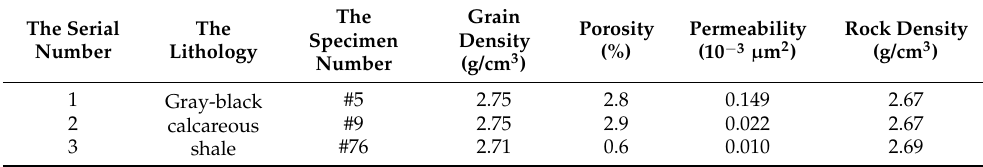
Table 1. The main physical characteristics of rock